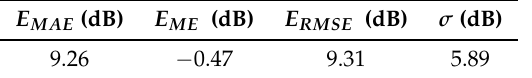
Table 2. Overall results of office environment 1.